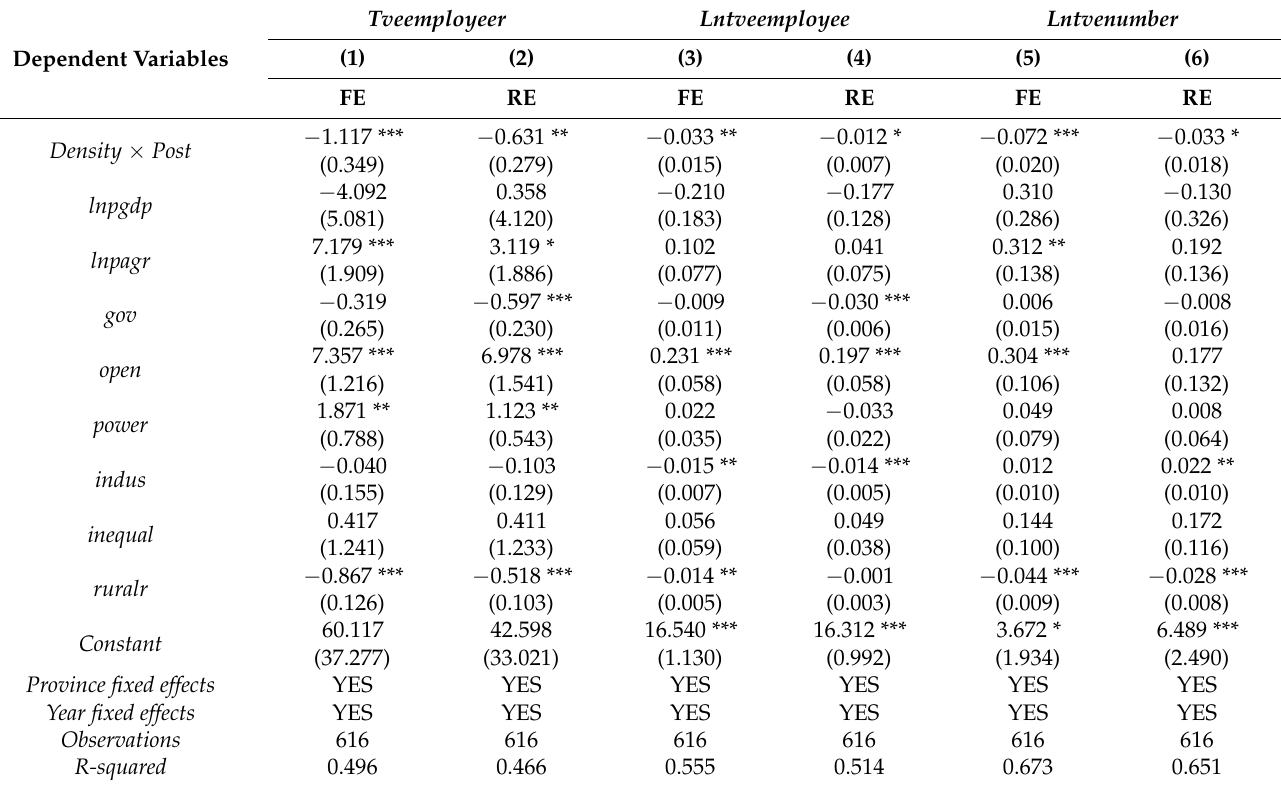
Table 6. The empirical results of the regulation of collective construction land and the decline of